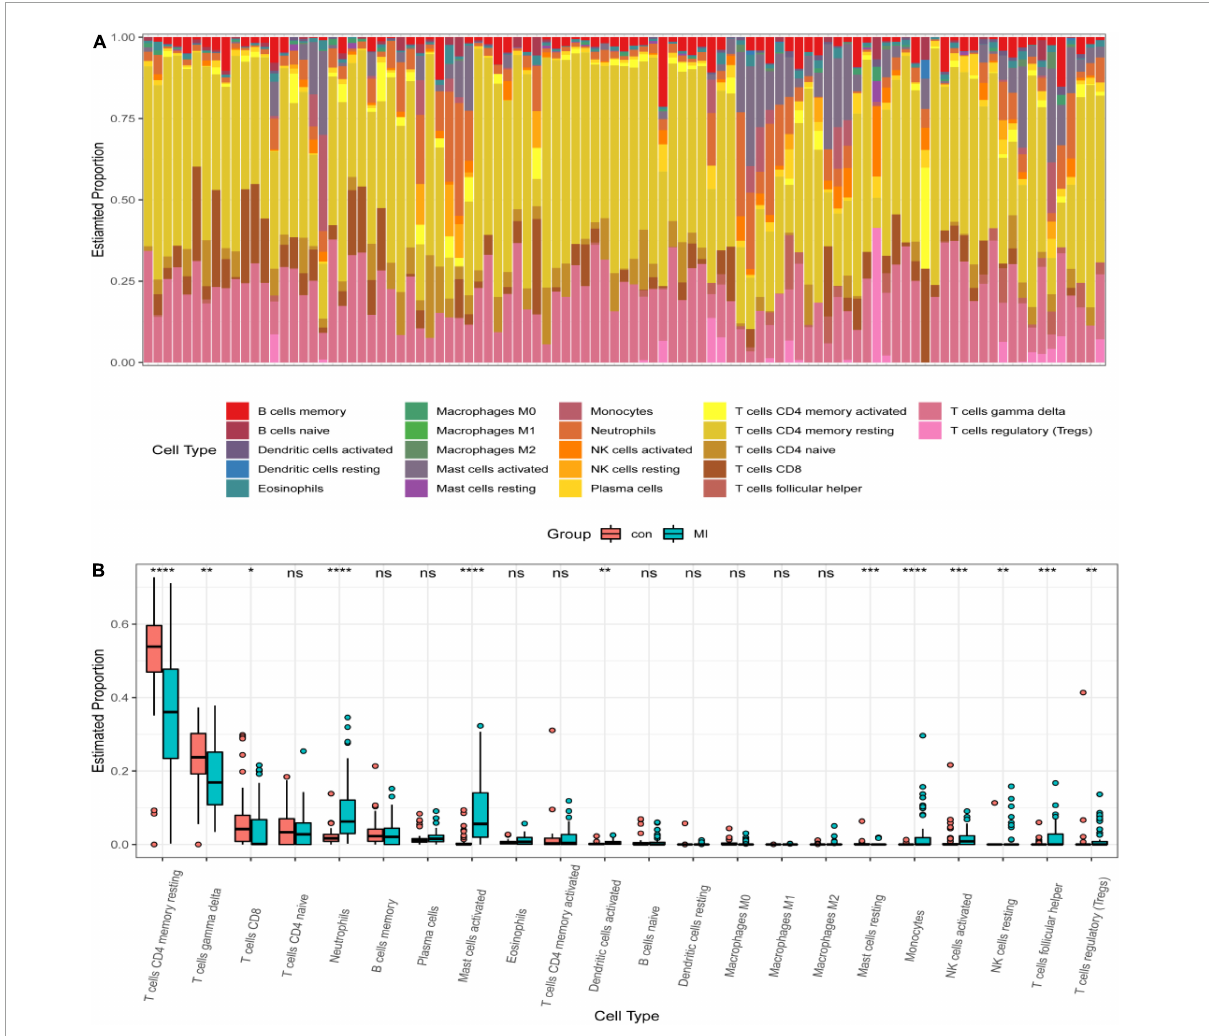
FIGURE8 Distribution of infiltrating immune cells. (A) A heatmap of the infiltrating immune cells. (B) Comparison of 22 immune cells between MI and CON groups. Red and green colors denote CON and MI groups,